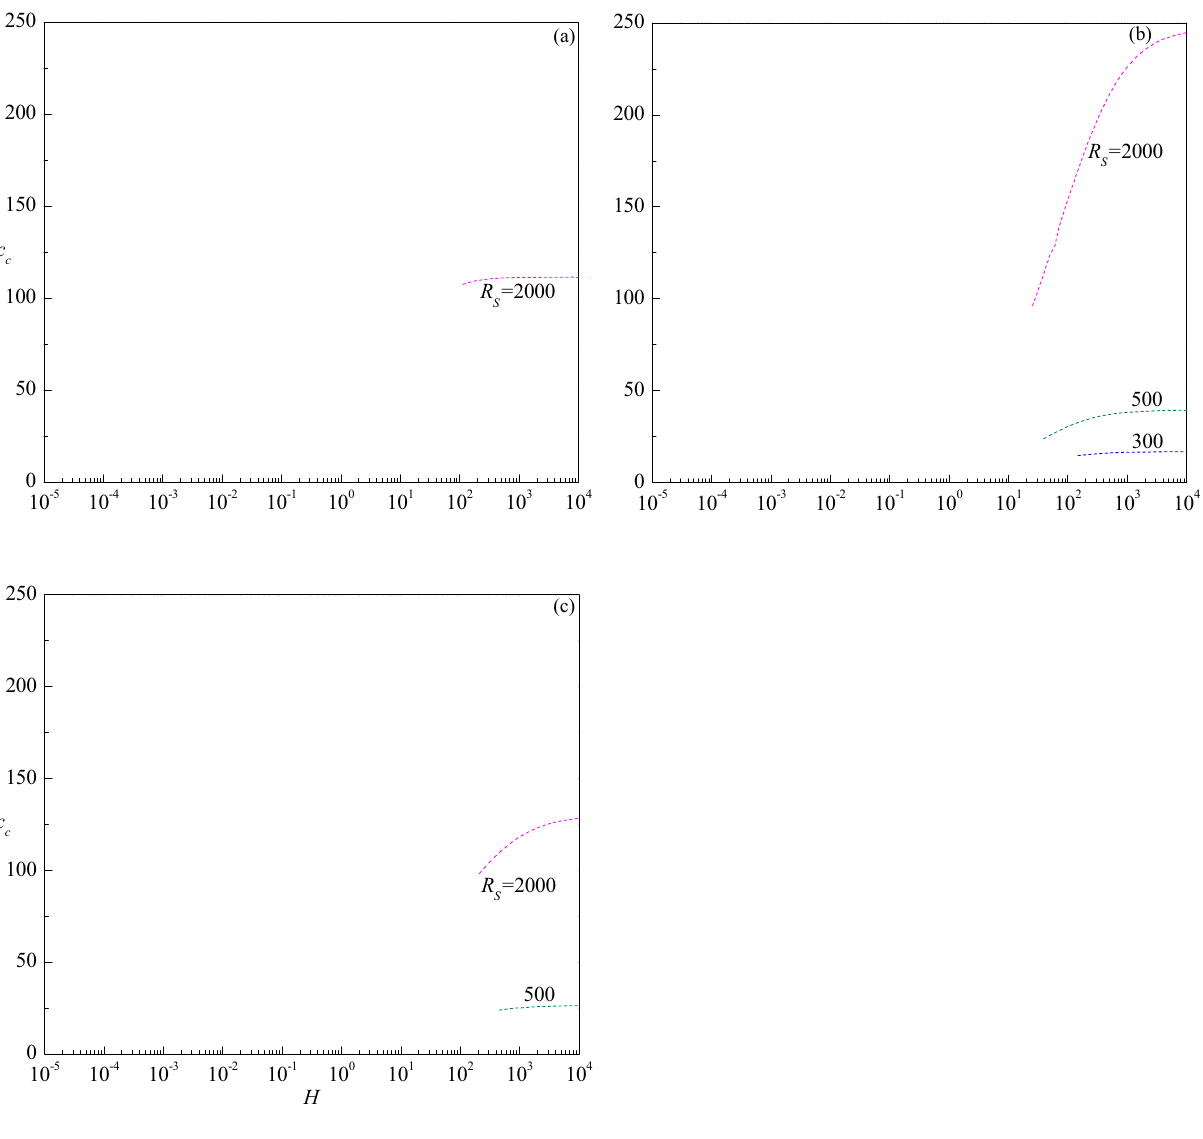
Figure 11. The variation of c c versus H for different values of R S relative to the cases ( a ) γ = 10 , ( b ) γ = 1 and ( c ) γ = 0.1 when Le = 2